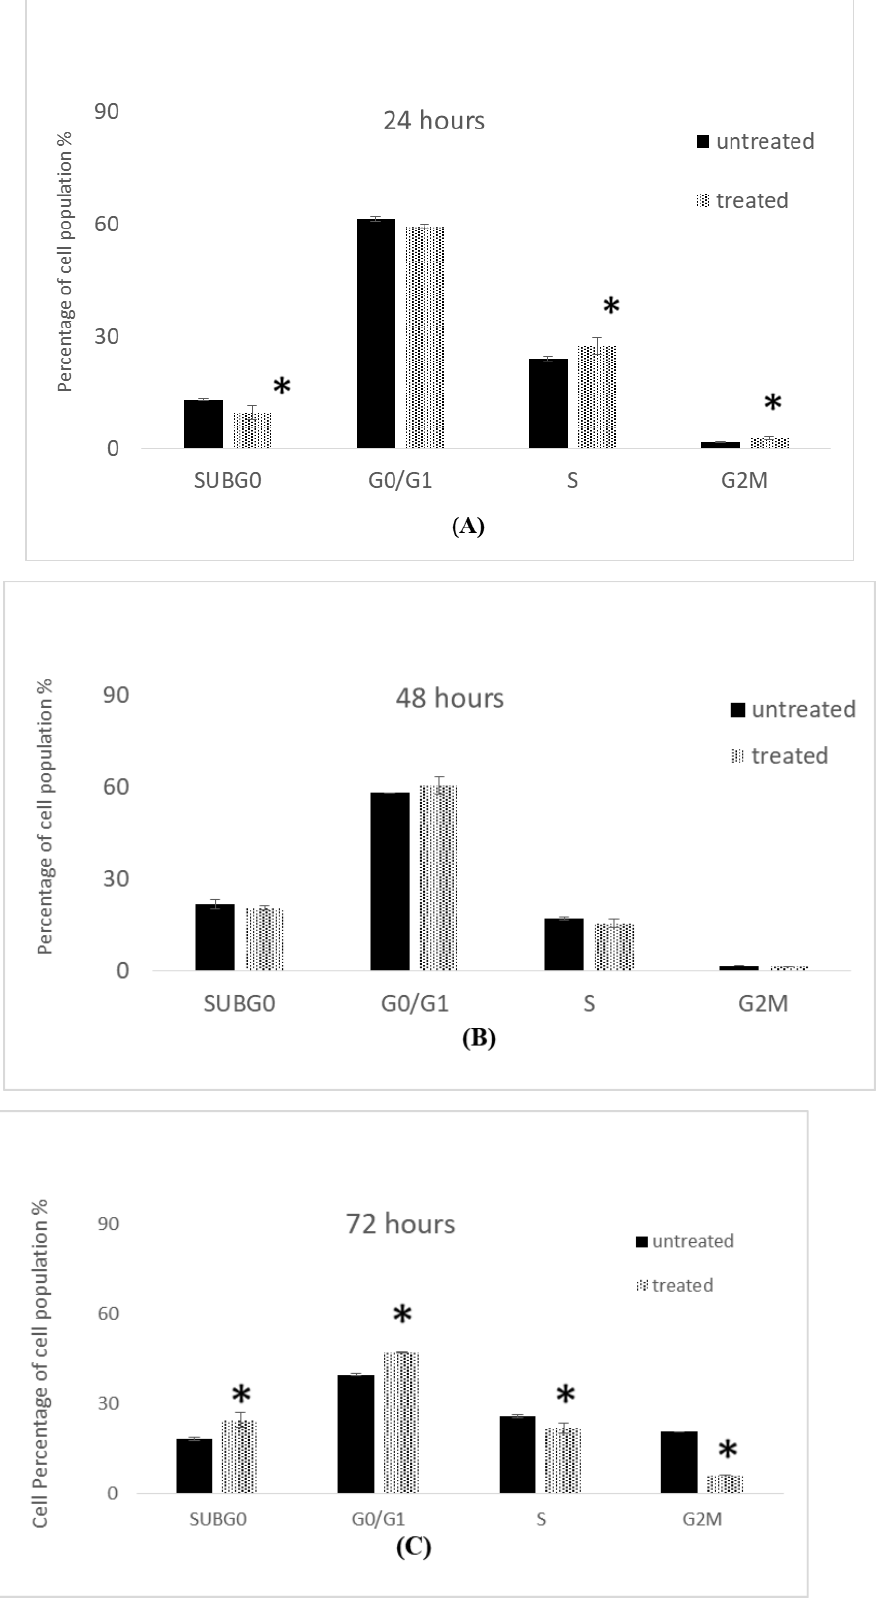
Figure 21. Cell cycle profile of MDA-MB-231 cells treated with 7-geranyloxycinnamic acid. Each data point represents the mean of three independent experiments ± SD. * Significantly different from the control ( p < 0.05). ( A ) 24 h, ( B ) 48 h and ( C ) 72 h of incubation. 2.6. Induction of Intracellular Reactive Oxygen Species (ROS) by 7-Geranyloxycinnamic Acid To quantify the fluorescence intensity of the H 2 DCF-DA dye in the cancer cell lines, the cells were treated with IC 50 concentrations of the pure compound and incubated for the time points indicated. Our findings show that two breast cancer cell lines exposed to 7-geranyloxycinnamic acid had alterations in fluorescence intensity compared to un- treated control cells. Treatment with 7-geranyloxycinnamic acid at a concentration of 4.96 µg/mL for 24 h resulted in a significant increase in fluorescent intensity (402.9%), indicat- ing the accumulation of ROS in MCF-7 cells line when compared to the untreated control cells (Figure 22). Accumulation of ROS in MCF-7 cells was more prominent (529.4%) after treatment with 7-geranyloxycinnamic acid at a concentration of 2.41 µg/mL for 48 h when compared to the untreated control. No significant ( p > 0.05) accumulation of ROS was ob- served after 72 h of exposure to 7-geranyloxycinnamic acid at an IC 50 concentration when compared to 48 h of incubation. 24